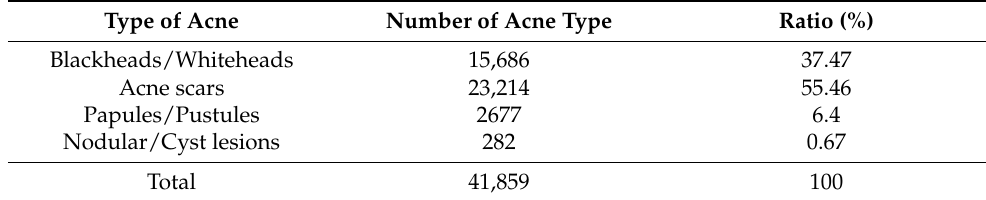
Table 1. Statistics of different types of acne.